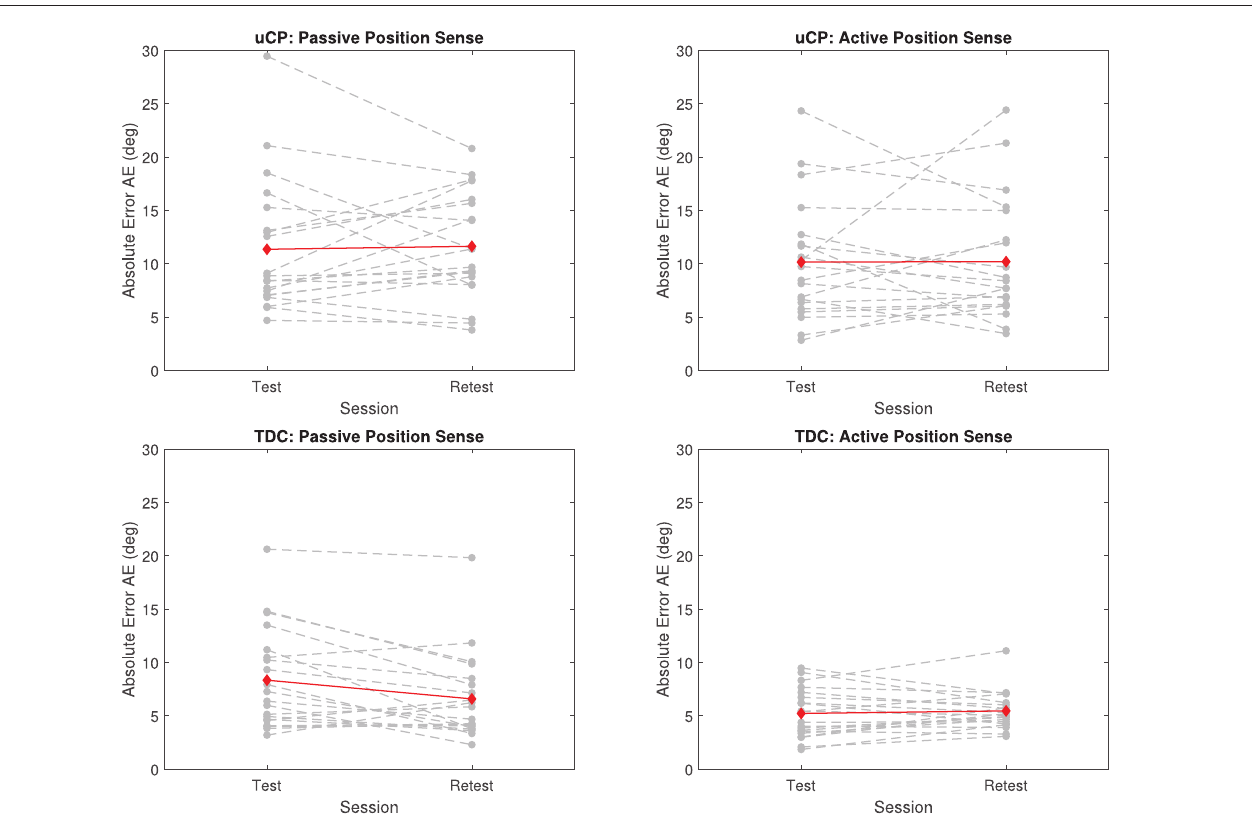
FIGURE 4 | Test-retest reliability in uCP and TDC for passive and active position sense. Gray dashed lines are individual participant’s data the red line indicates the mean across all participants at test and retest. Both hands are considered together in the figure (dominant and non-dominant hand, hence N = 20).